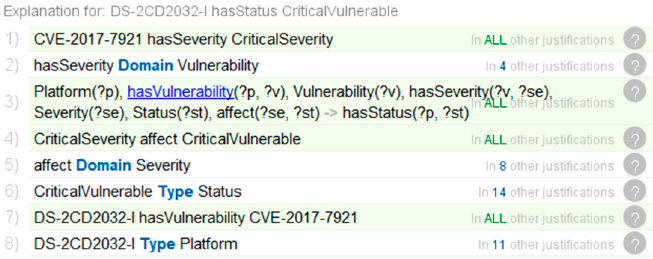
Sensors 2021 , 21 , x FOR PEER REVIEW Figure 10. ( a ) Results from the application of inference rules; ( b ) The joint inference process.